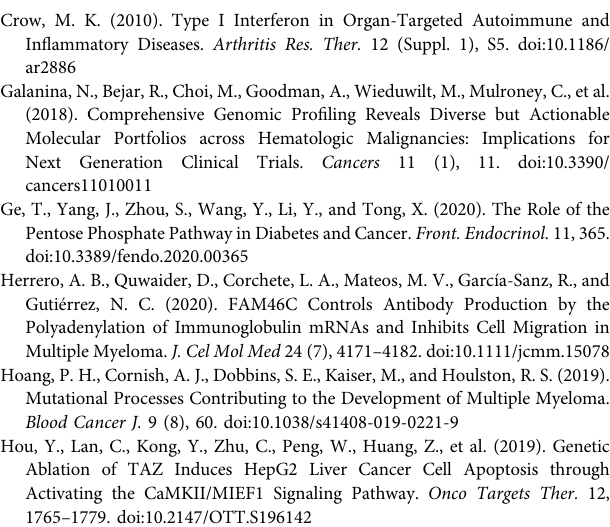
Supplementary Figure 1 | FAM46C expression in pan-cancer with different World Health Organizationstages. The differential expression of FAM46C isnot statistically signi fi cant( p > 0.05)intheWHOstagingofdifferentcancertypesinTCGAdatabase. Supplementary Figure 2 | Analysis of the association between FAM46C expression and stromal scores using the Spearman ’ s rho test. The data with p < 0.05 are plotted. Supplementary Figure 3 | Analysis of the association between FAM46C expression and immune scores using the Spearman ’ s rho test. The data with p < 0.05 are plotted. Supplementary Figure 4 | Analysis of the association between FAM46C expression and the ESTIMATE scores using the Spearman ’ s rho test. The data with p < 0.05 are